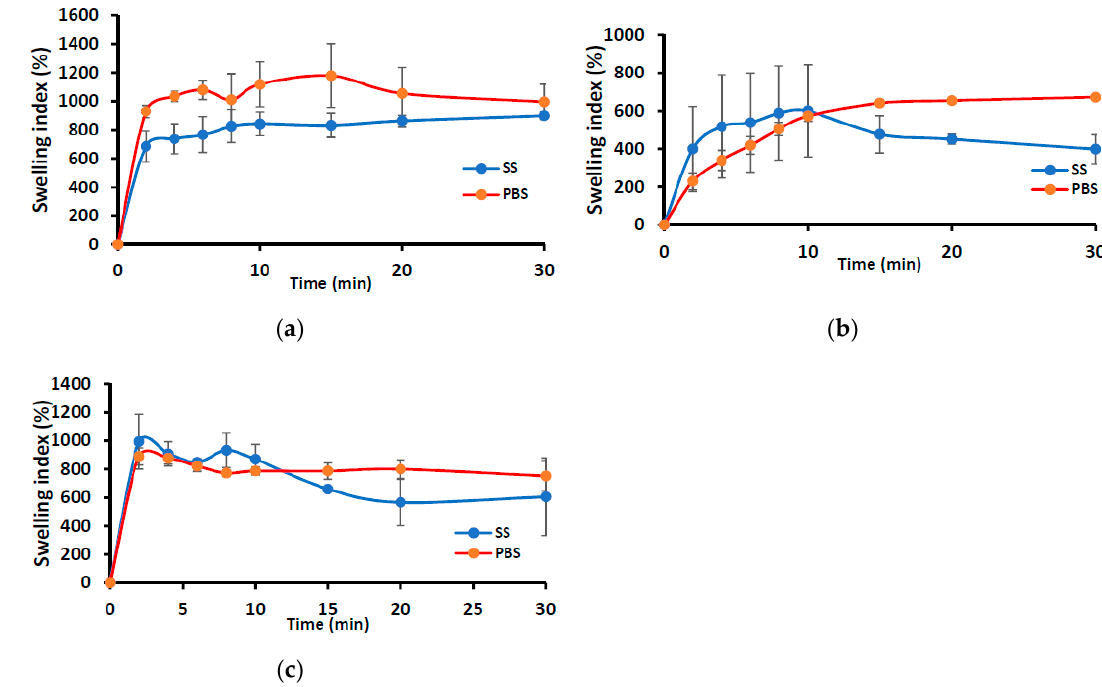
Figure 1. Swelling profiles (i.e., % swelling index against time) of ( a ) MAS wafer, ( b ) MAS film, and ( c ) non-MAS wafer in SS and PBS ( n = 3, ± SD).